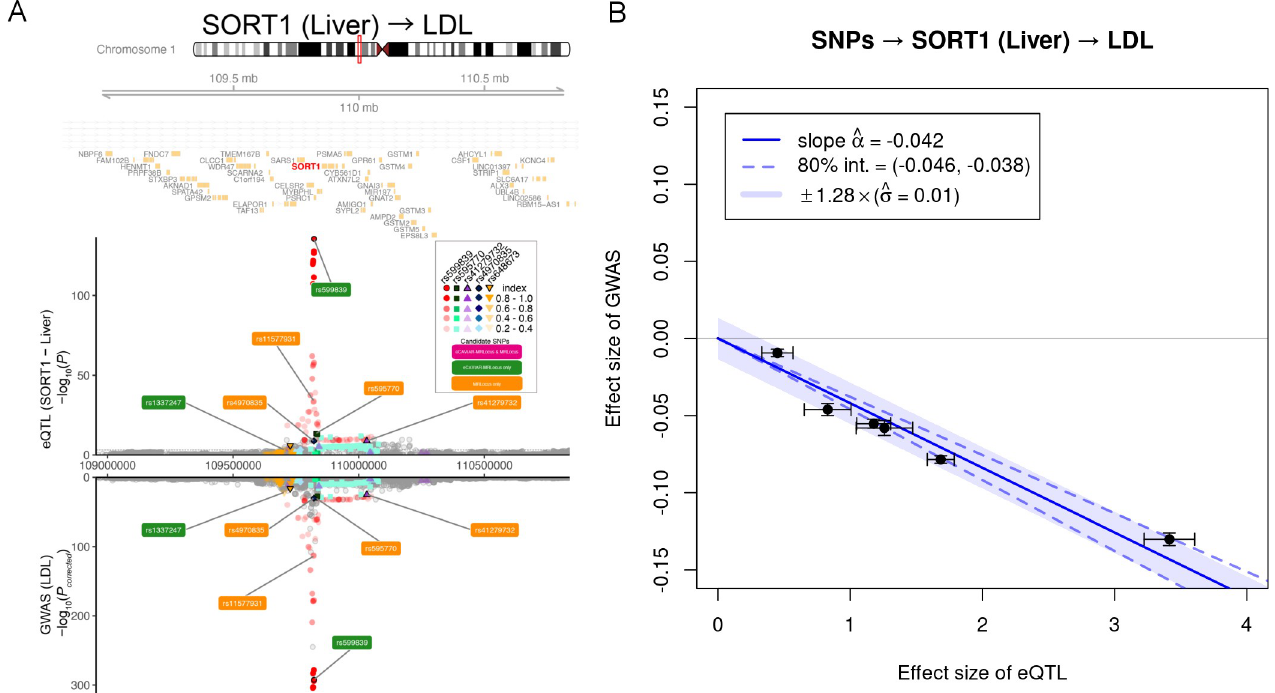
Fig 4. Colocalization and MRLocus estimation for SORT1 . (A) Colocalized signals in the SORT1 region. From top panel to bottom, gene model (NCBI Refseq), eQTL for SORT1 in liver (N = 588) (Strunz et al., 2018) and LDL association within UKBB (N = 343,621). Dashed line indicates a significance threshold at p = 0.001 or p = 5x10 -8 for eQTL and GWAS respectively. Colored labels indicate eSNPs used for slope fitting with both methods, eCAVIAR-MRLocus, or MRLocus. (B) MRLocus plot of the gene-to-trait effect for SORT1 expression in liver on LDL levels. The signal clusters all provide consistent evidence for a gene-to-trait effect of -0.042, meaning that doubling of gene expression level in liver should reduce LDL by 4.2% of its population standard deviation. An 80% credible interval for the slope is indicated by dashed blue lines around the solid blue slope, while a range of heterogeneity of allelic effects is indicated by the light blue